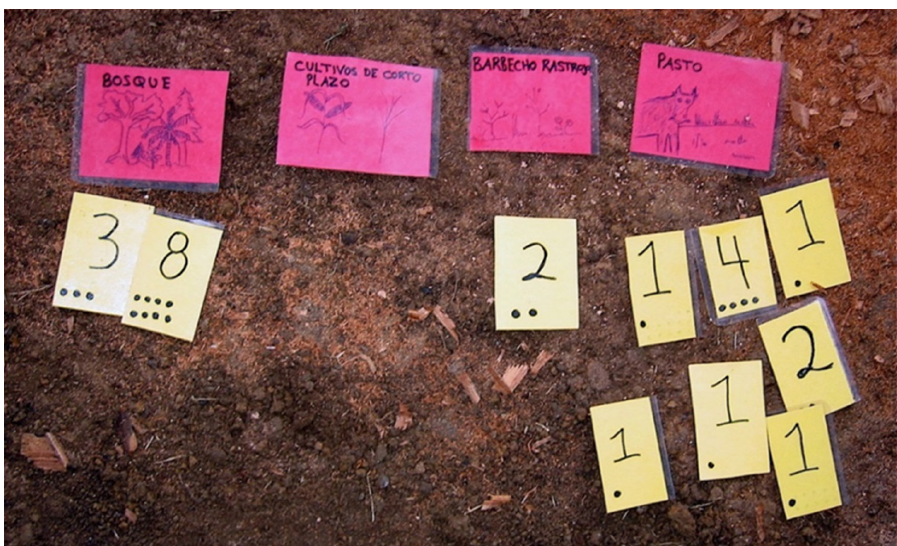
Figure 2. Cards Denoting Land Use/Covers (Red) and Number of Hectares (Yellow) Used to Reconstruct Household Land-Use Histories. Note: in this photo, the columns of cards indicate that there were 38 hectares in forest (bosque), two hectares in fallow (barbecho rastrojo), and a sum of 11 hectares in pasture (pasto) for the year in question. The notable accumulation of multiple small-denomination cards under the pasture card is indicative of the fact that, in any given year, only one or two hectares would typically have been taken from forest for subsistence agriculture (cultivos de corto plazo), which would subsequently be passed to fallow (as shown) and then ultimately to pasture, where it would remain.